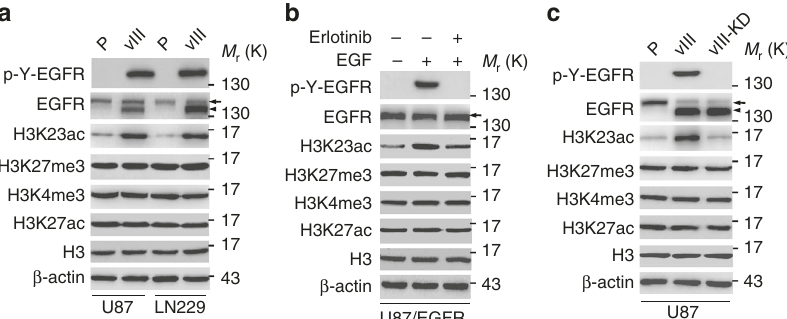
Fig. 1 EGFR signaling enhances H3K23ac expression in GBM cells. a Effects of EGFRvIII overexpression on histone H3 methylation and acetylation in U87 and LN229 GBM cells. P, parental cells; vIII, U87 or LN229 cells expressing EGFRvIII. b Erlotinib treatment inhibited EGF-stimulated EGFR phosphorylation and H3K23 acetylation in U87 GBM cells stably expressing EGFR. EGF (20 ng/ml) stimulated U87 GBM cells with, or without, erlotinib (10 μ M) for 24 h. c Western blotting (WB) analysis of the effects of kinase dead EGFRvIII (EGFRvIII-KD) on H3K23ac expression. Data in a – c are representative of three independent experiments. β -actin and histone H3 (H3) were used as loading controls. Arrows, EGFR. Arrow heads,